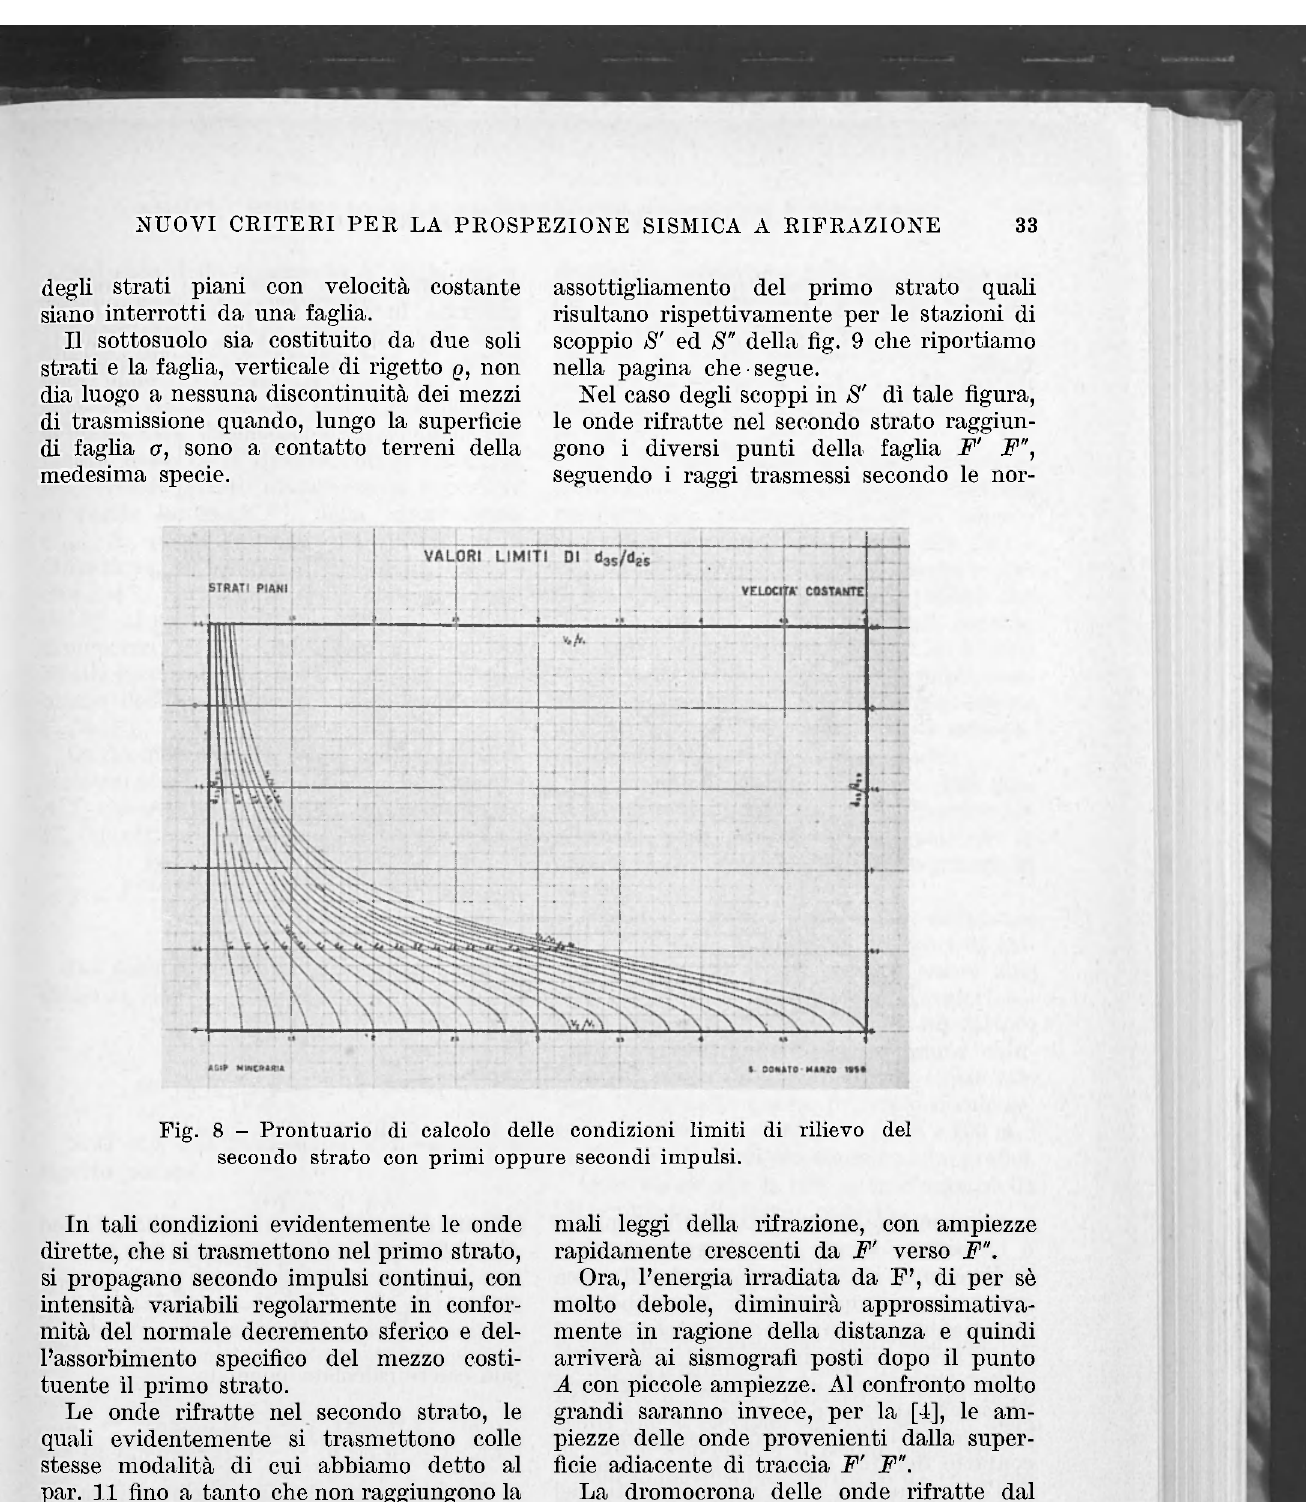
Fig. 8 - Prontuario di calcolo delle condizioni limiti di rilievo del secondo strato con primi oppure secondi